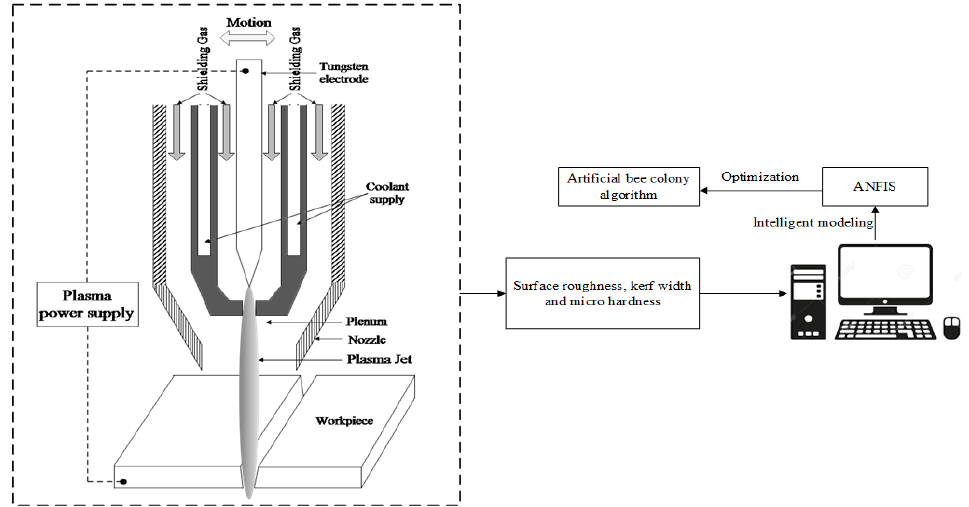
Figure 5. Schematic representation of the experimental set-up. Table 1. Selected PAC parameters and their levels.